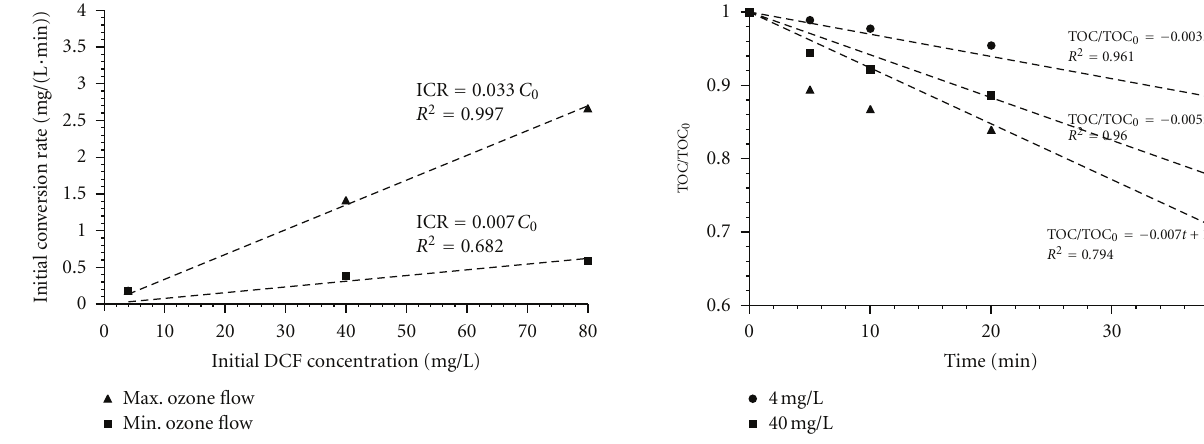
Figure 3: Initial DCF conversion rates, in terms of absorbance, by ozonation (ozone flow = 31 g/h).